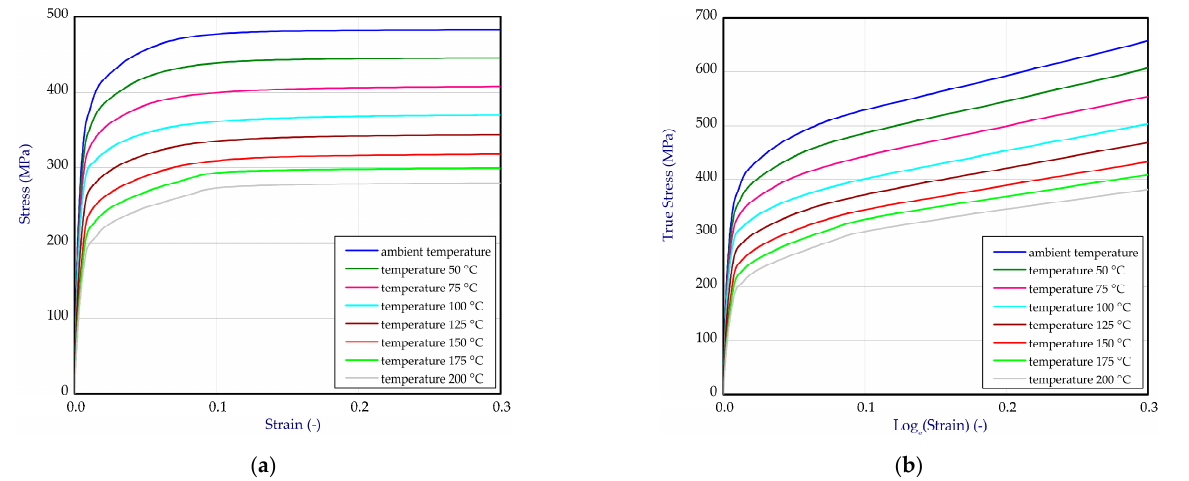
Figure 3. The tensile curves of titanium ( a ) and curves after transformation into true stress-logarithmic strain relation ( b ).